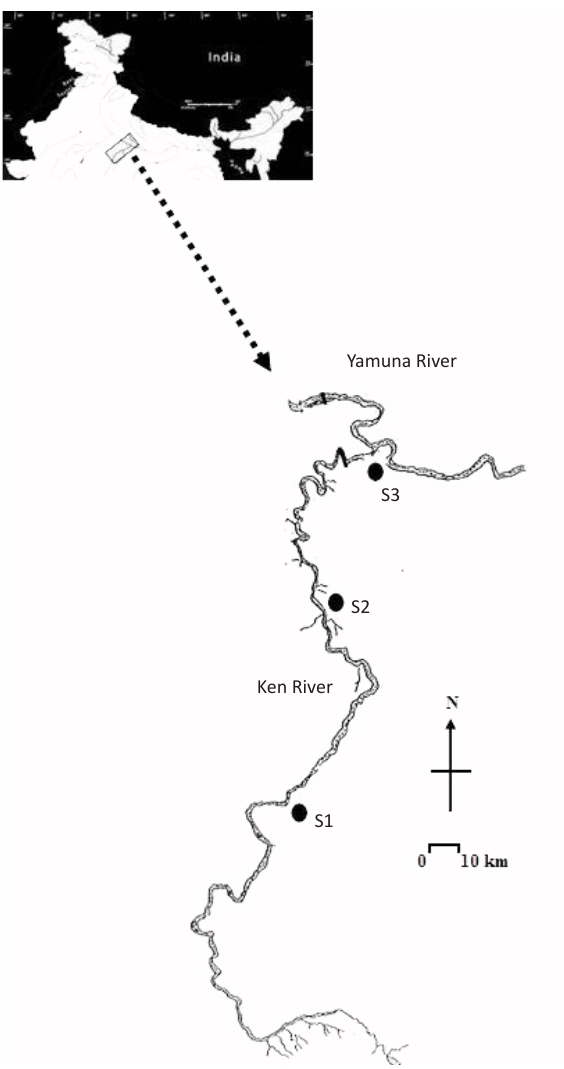
Figure 1. location of the Ken River in India and sampling stations (S1 to S3) selected for the study.